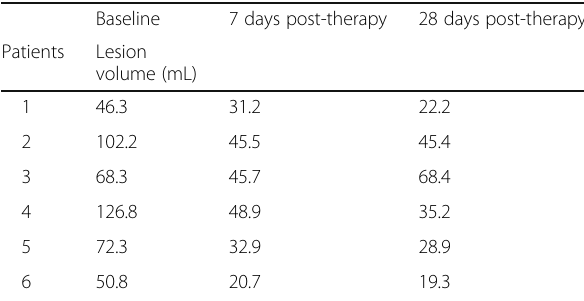
Table 2 Lesion volumes as assessed on the [ 18 F]FLT PET scans at the three time points: baseline, 7 days post-therapy and 28 days post-therapy